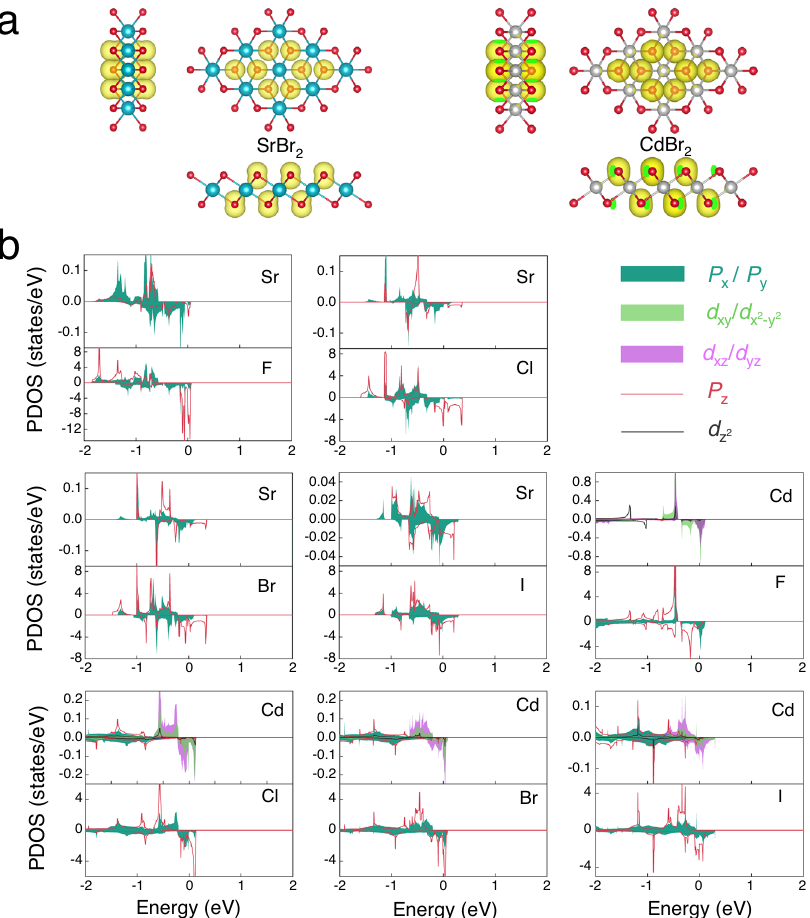
Fig. 5 Spin densities and orbital projected density of states of the selected 2DHDFM. Spin density plots ( a ) and orbital projected density of states ( b ) for P3m1 strontium dihalides and cadmium dihalides monolayers at hole density of 6 × 10 14 cm − 2 . Positive (negative) values refer to up (down) spins. The Fermi level is set at zero On the other hand, J 2 corresponds to the in-plane exchange coupling between two halogens from the same atomic plane, see Fig. 6a. In this case, the direct exchange interaction between the anion p- orbitals is weaker since the in-plane halogen-halogen distance is larger. Consequently, the indirect exchange interaction, involving the coupling between the halogen- p orbitals with the metal orbitals, should also play an important role in the next- nearest neighbor interaction. Group IIA and IIB metals are transferring their two outmost valence electrons to the halogens p -orbitals, to form the dihalide compounds. In the indirect exchange mechanisms, it is assumed that some covalent mixing between the cation and anion orbitals is energetically favorable. From the projected electronic density of states (PDOS) of strontium and cadmium dihalides, shown in Fig. 5b, one can indeed visualize the possible hybridization between the (spin- down) p orbitals of the halogen and the (spin-down) p or d orbitals of the metals near the Fermi level; note that for group IIB metal dihalides, the degeneracy between the metal d orbitals is partially lifted by the distorted octahedral crystal fi eld, resulting in the formation of e 1 ( d xz and d yz ), e 2 ( d x 2 (cid:2) y 2 and d xy ) and a 1 ( d z 2 ) states. Speci fi cally, the in-plane halogen- p x / p y orbitals can couple to metal- p x / p y orbitals and halogen- p z orbitals couple to metal- p z orbitals for strontium halides. For cadmium dihalides, the halogen- p x / p y orbitals couple to metal- d x 2 (cid:2) y 2 / d xy and d xz / d yz orbitals, and the halogen- p z orbitals also hybridize with the d xz / d yz orbitals. From Table 1, J 2 of group IIA metal dihalides can be positive or